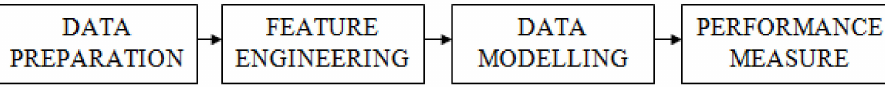
Figure 18. Methods of building the machine learning